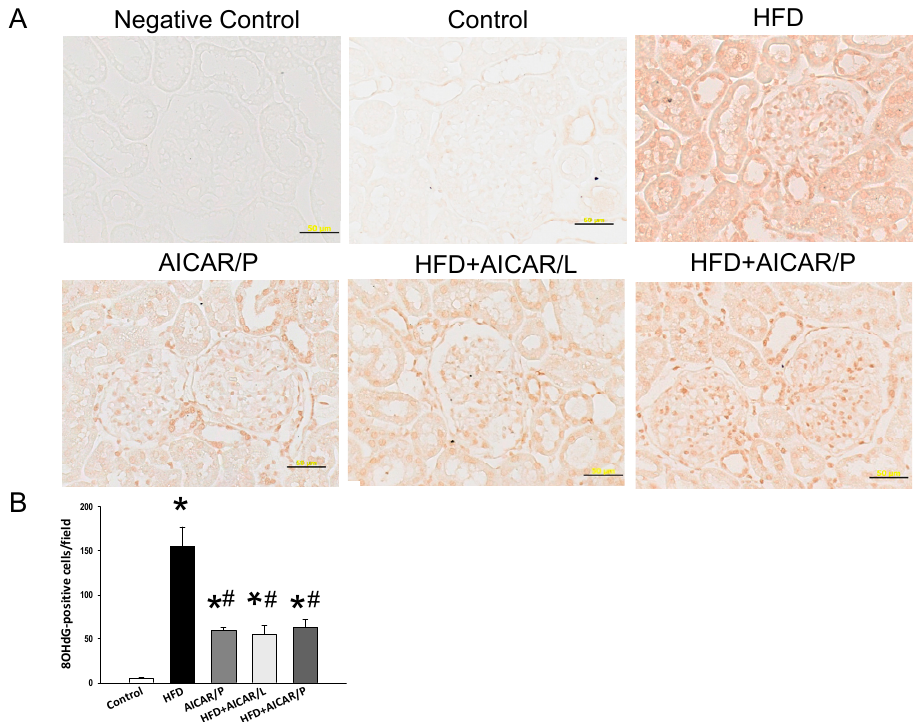
Figure 6. ( A ) Light microscopic findings of 8-hydroxydeoxyguanosine (8-OHdG) immunostaining in the kidney cortex in 16-week-old male offspring. Bar = 50 μ m; ( B ) quantitative analysis of 8-OHdG-positive cells per microscopic field (×400); * p < 0.05 vs. control, # p < 0.05 vs. HFD.